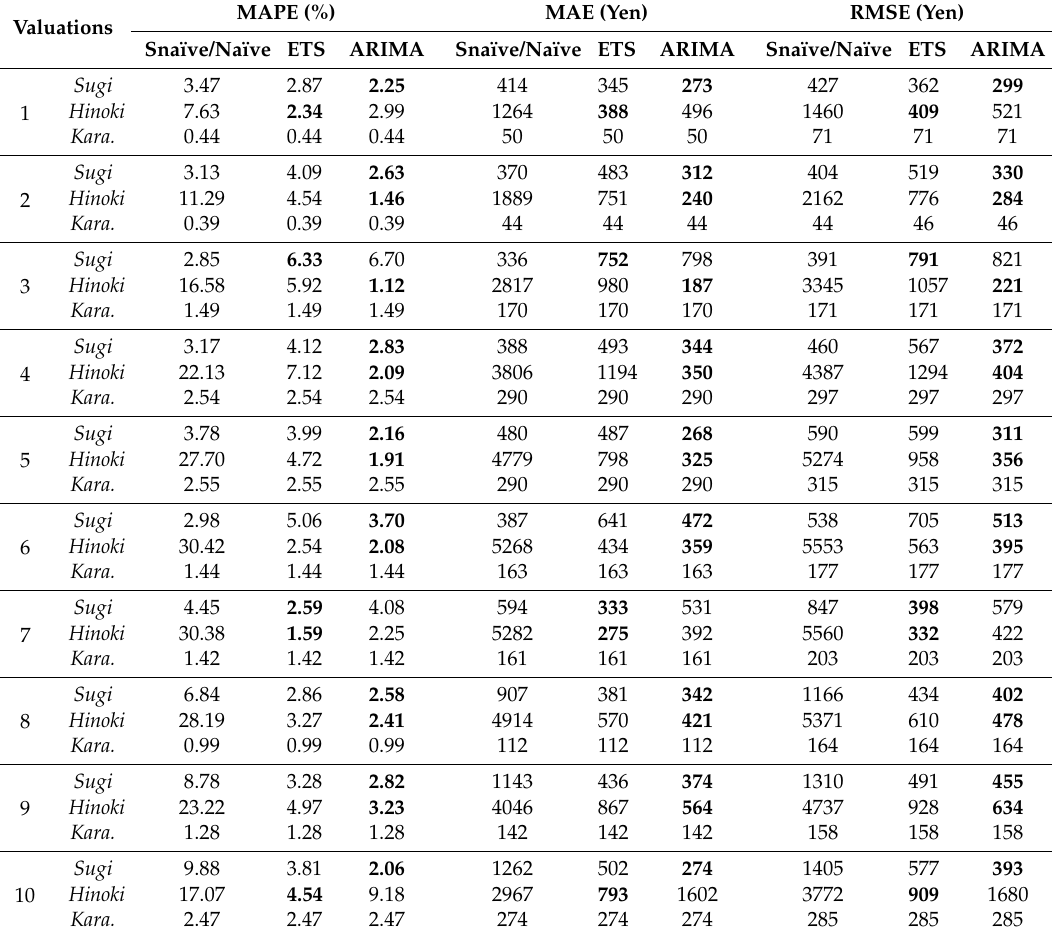
Table 3. Forecast errors for 6-months-ahead forecasts. “ Kara .” stands for karamatsu . The smallest error among the three methods are shown in bold letters. Snaïve method is applied to sugi and hinoki , while naïve method to karamatsu